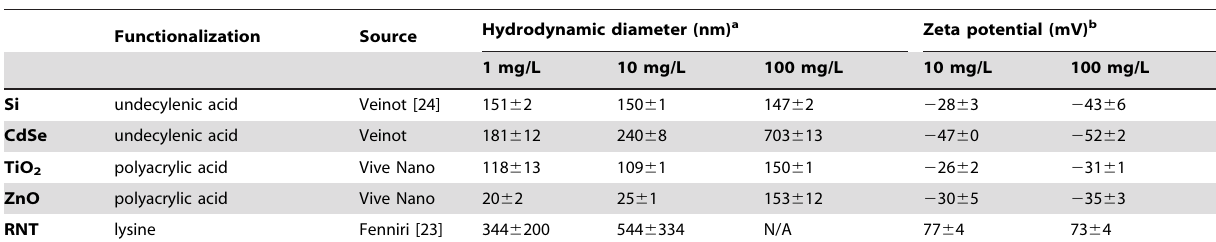
Table 1. Physicochemical characterization of nanoparticles.